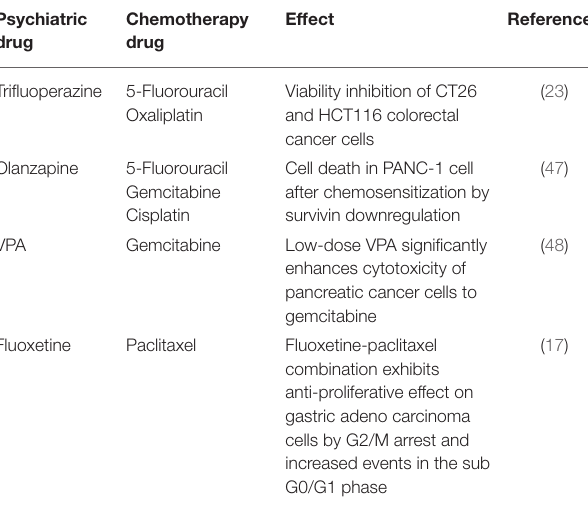
TABLE 1 | Synergistic effects of PDs and chemotherapeutic agents in GICs. Psychiatric Chemotherapy drug